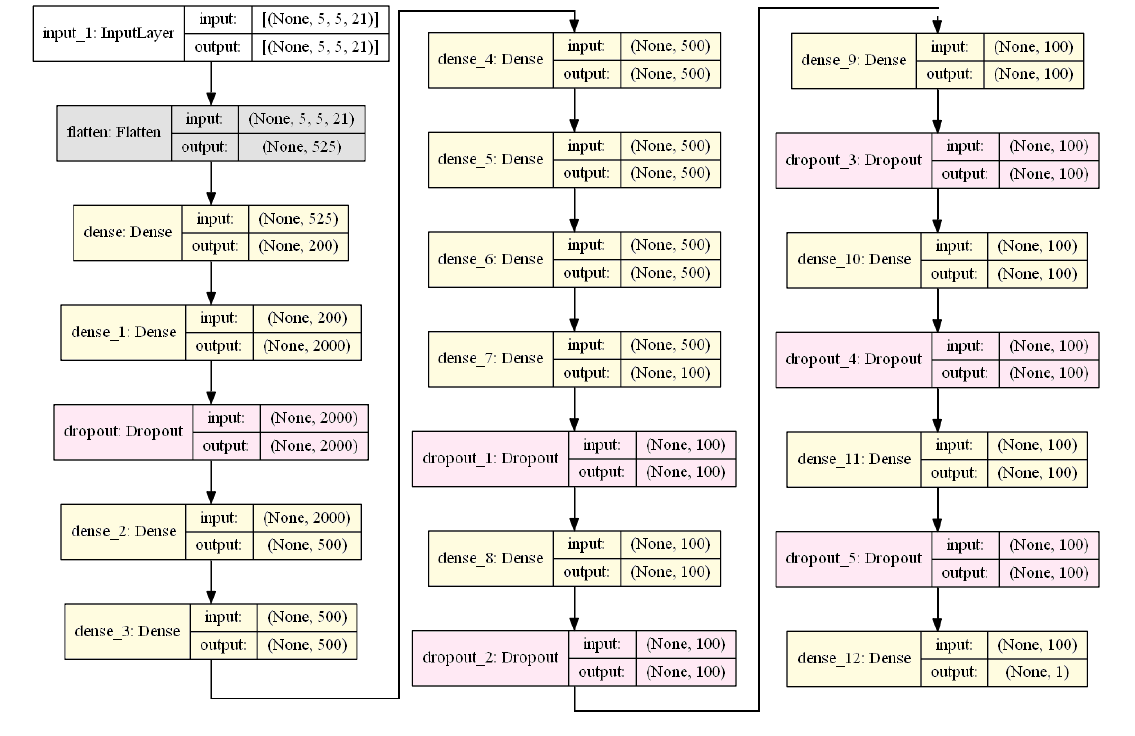
Figure 5. The architecture of our DNN model. Color scheme: white—input layer; gray—flatten layer; yellow—dense layer; pink—dropout